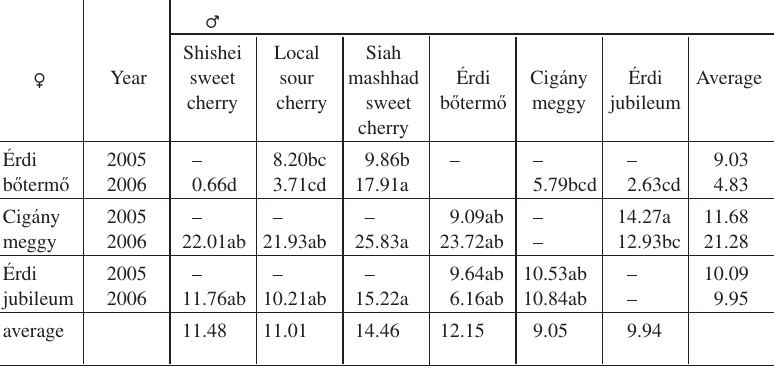
Table 4 . Cross pollination of sour cherry cultivars by sweet and sour cherry pollens